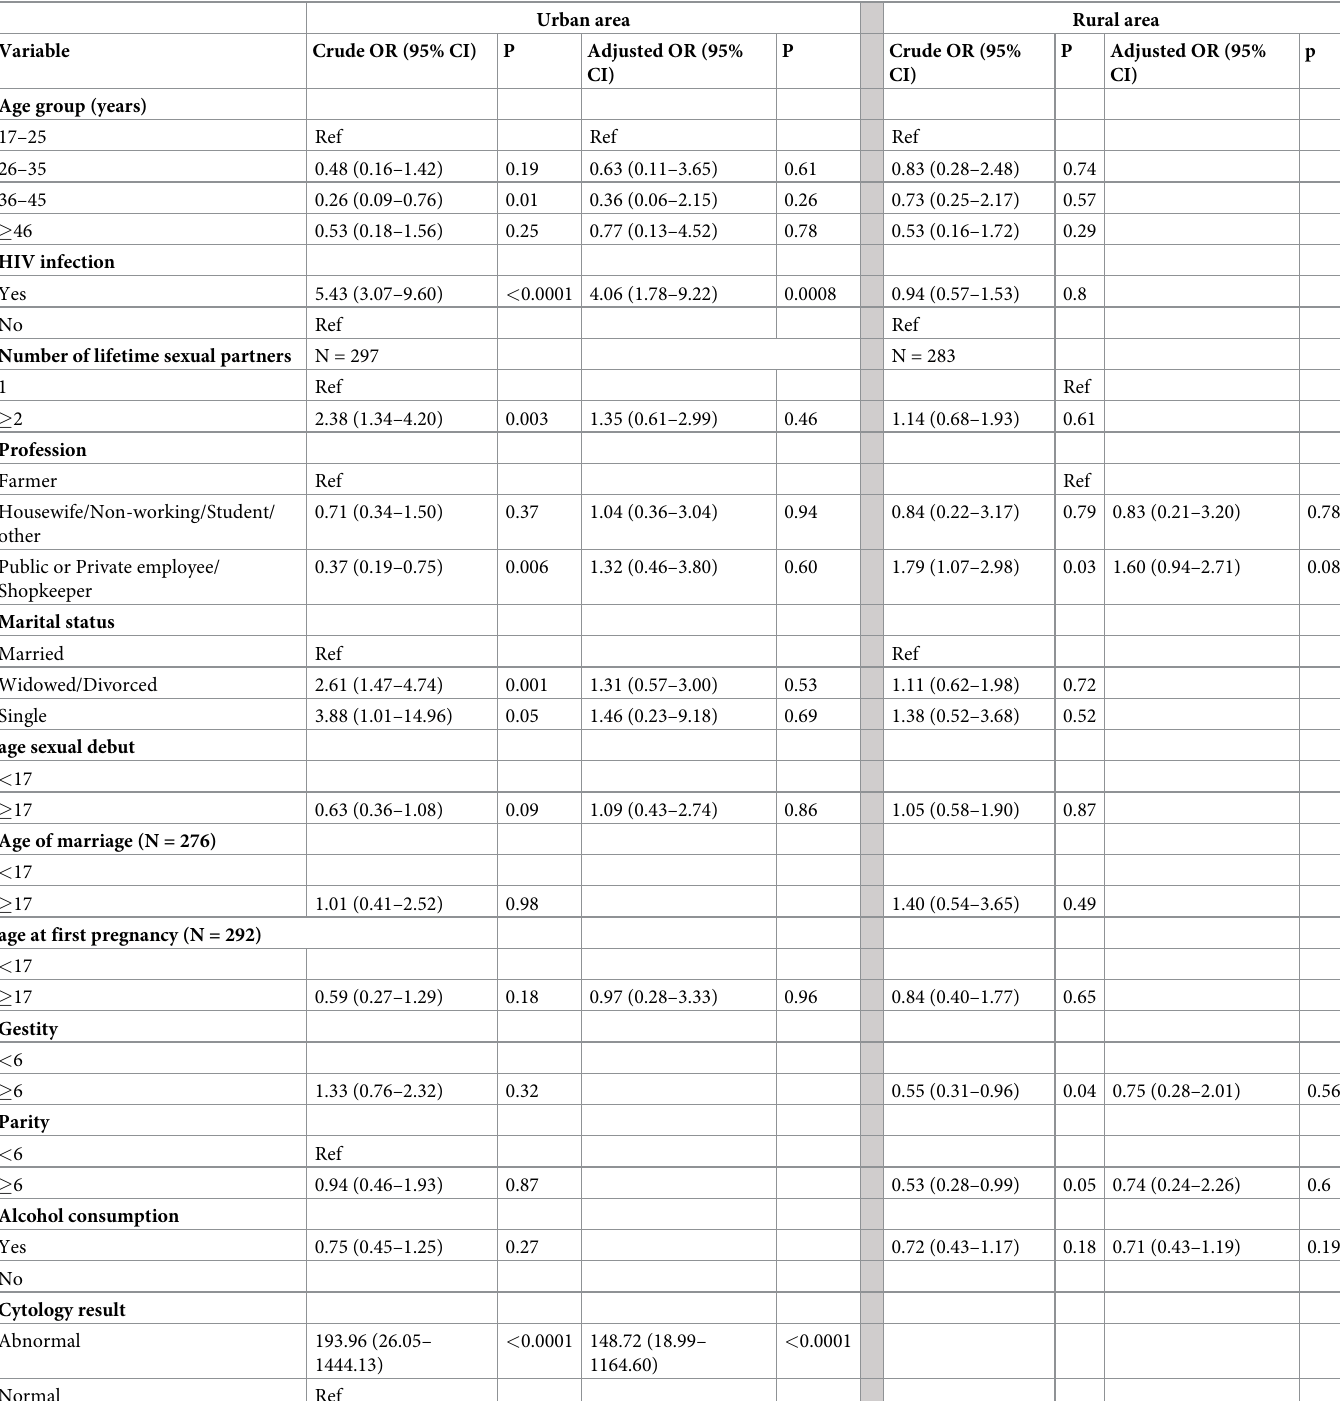
Table 4. Predictors of the HPV (any) infection by study area (rural and urban) in women, Burundi. Urban area Rural